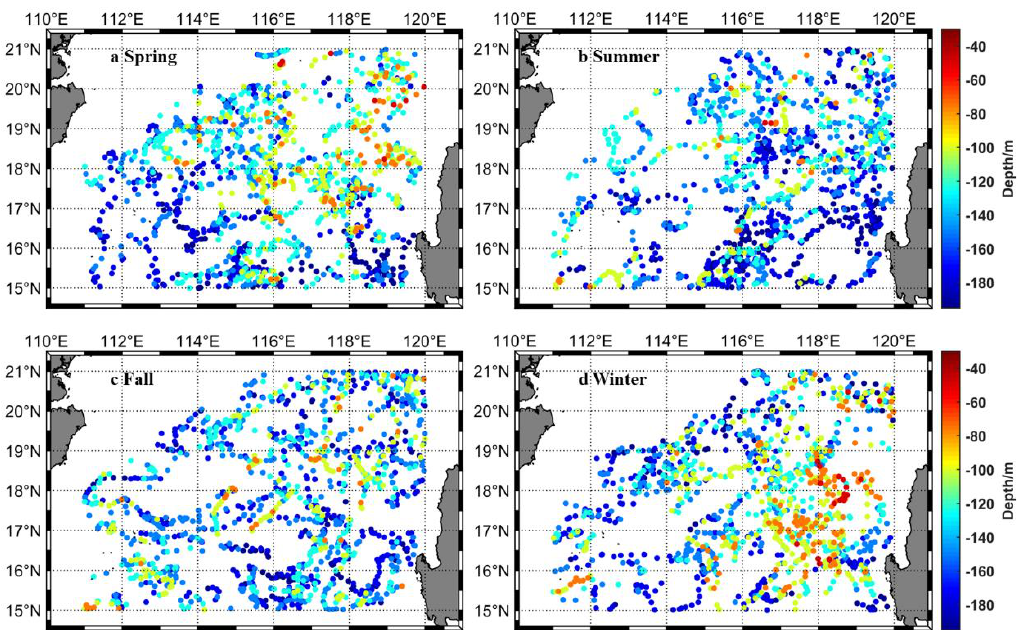
Figure 5. Seasonal variation of the salinity (psu) in the salinity-maximum layer.